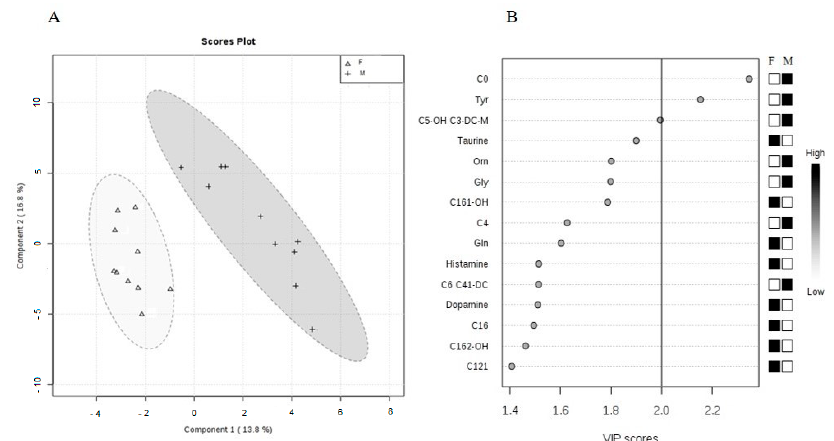
Figure 5. ( A ) Partial least squares-discrimination analysis (PLS-DA) of selected metabolites in male and female animals (PLS-DA scores’ plot includes two components: R2 = 0.93659 and Q2 = 0.44597). In the graphical output, 95% confidence ellipses for specific groups are included. ( B ) Variable importance in projection (VIP) plot, calculated from PLS-DA method, displays the top 15 most important metabolite features identified by PLS-DA. White and black boxes on right indicate relative concentration of corresponding metabolite in blood in descending order of importance. VIP is a weighted sum of squares of the PLS-DA loadings considering the amount of explained Y-variable in each dimension. The most important features have the VIP values of >2.0.